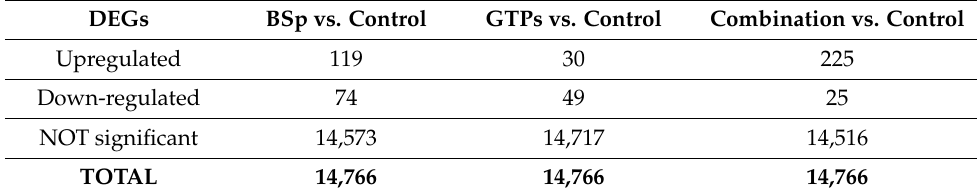
Table 2. Total number of DEGs across the different treatment groups. DEGs BSp vs. Control GTPs vs. Control Combination vs.